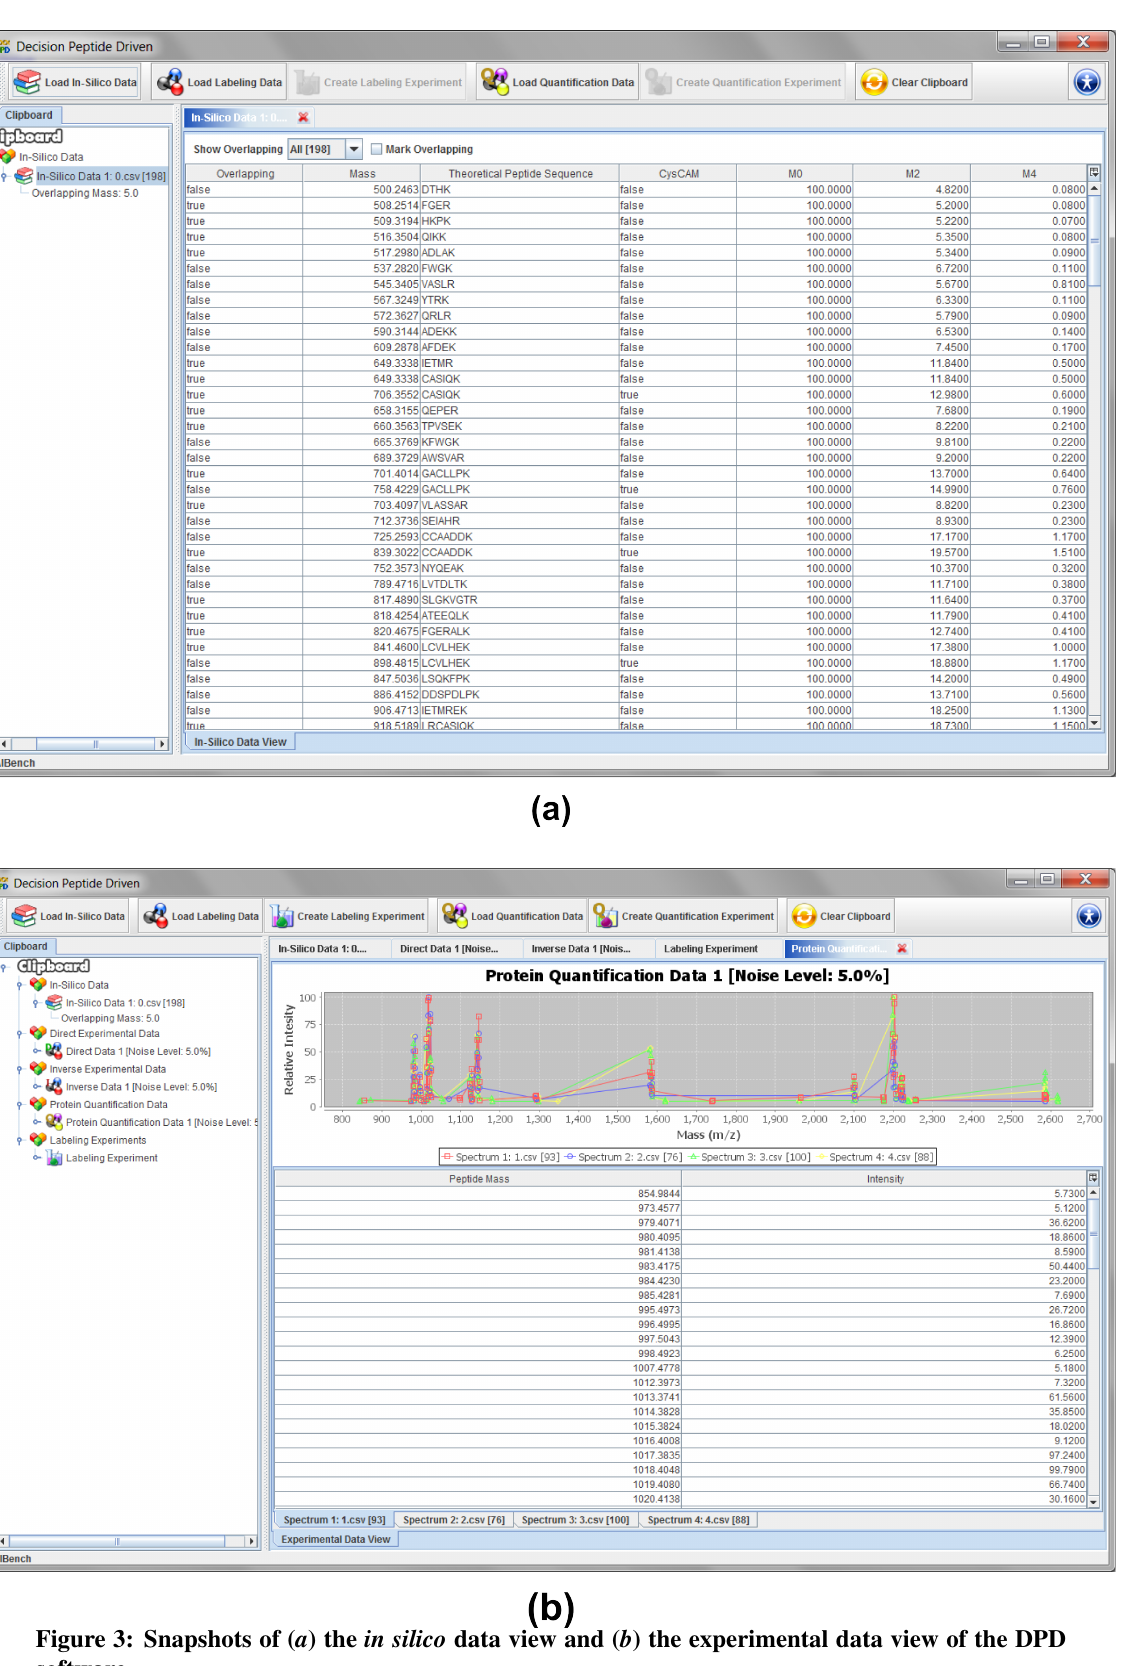
Figure 3: Snapshots of ( a ) the in silico data view and ( b ) the experimental data view of the DPD